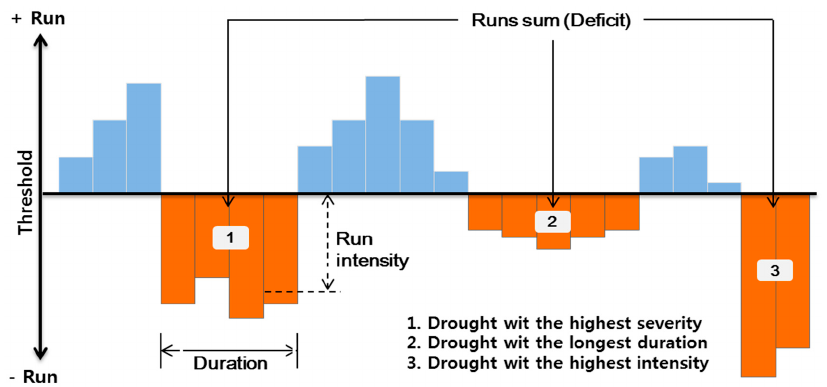
Figure 1. Drought characteristics using the run theory for a given threshold level [36].